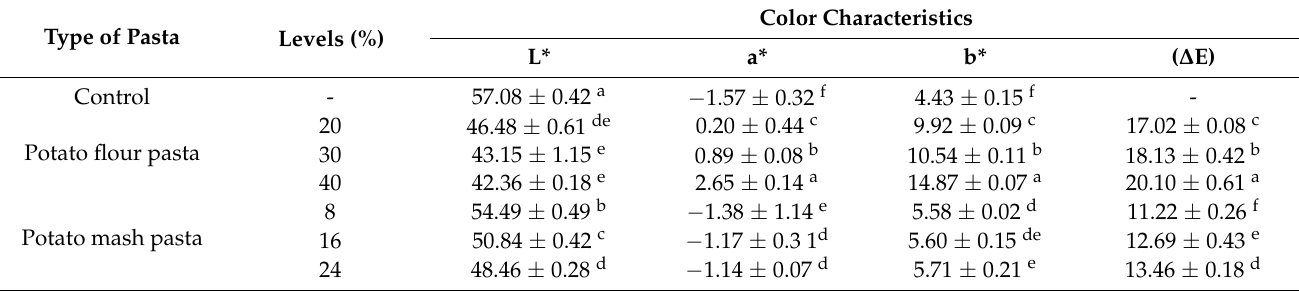
Table 5. Effect of replacing potato powder and mash with semolina on the color characteristics of pasta. Type of Pasta